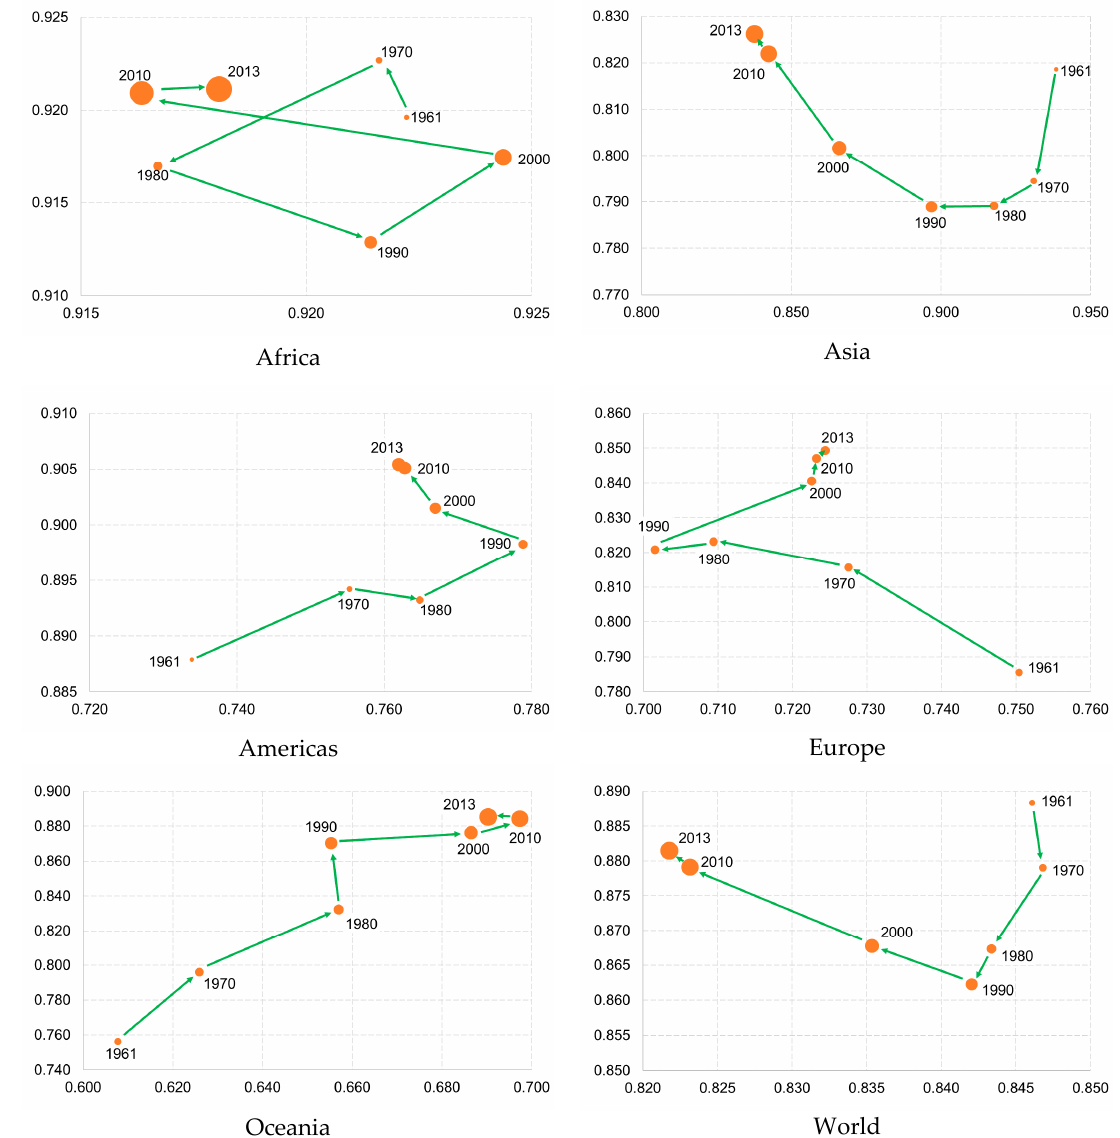
Figure 2. Evolution of the diet situation by macro-region and for the world as a whole, 1961 to 2013. In all charts: y -axis: Simpson’s index of diversity of vegetable products; x -axis: share of vegetable products in total calorie supply (%); bubble width = total calorie supply (kcal/year).